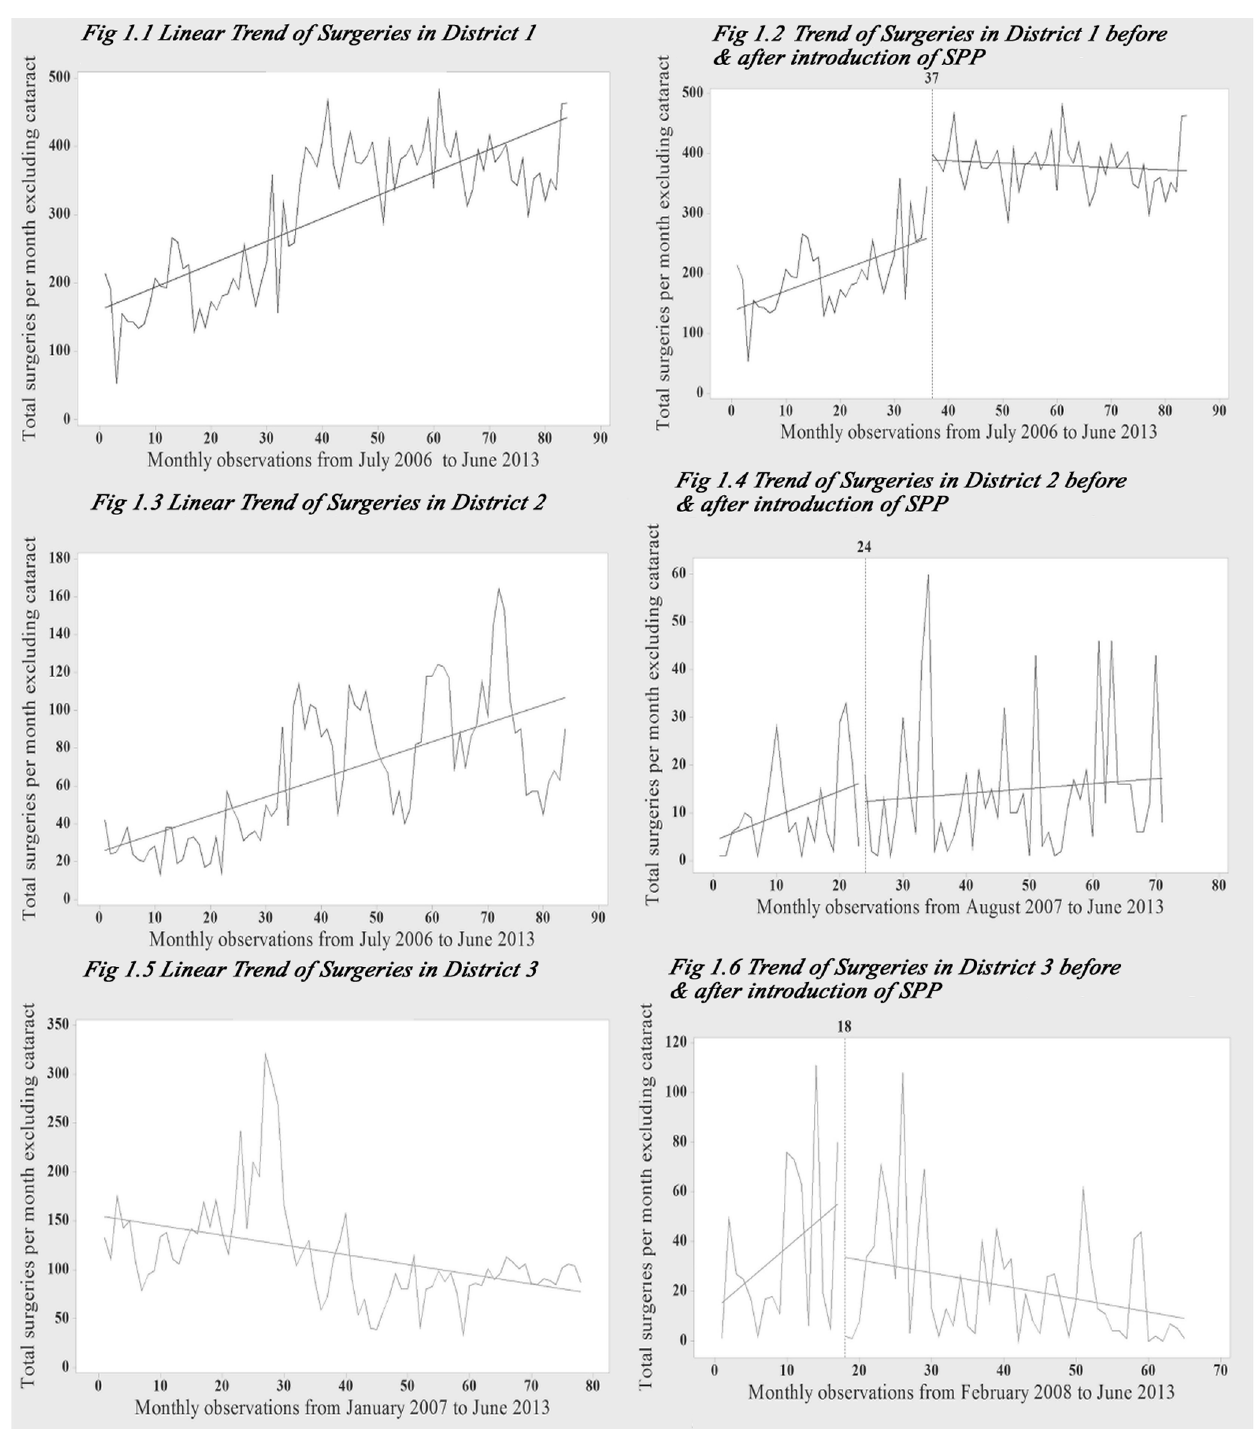
Fig 1. Trend of surgical care utilization, before and after the introduction of user charges in districts Panchkula, Rohtak and Gurgaon. Month-wise data on the number of surgeries performed at district hospitals was collected from the districts for the period from July 2006 to June 2013 in Panchkula, Rohtak, and from January 2007 to June 2013 for Gurgaon. Fig 1.2: Unadjusted model was chosen for Panchkula, as it showed no positive autocorrelation or seasonality. Fig 1.4: The model for Rohtak was adjusted for both, first-order correlation and seasonality. Fig 1.6: The model for Gurgaon was adjusted for both, first-order correlation and